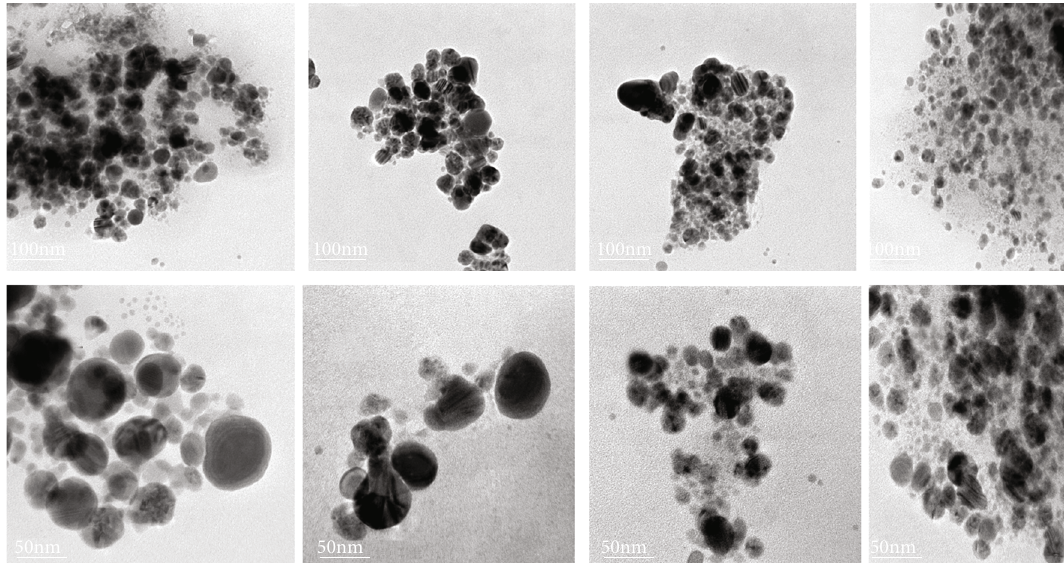
Figure 3: HR-TEM images of HAART-AgNPs (0.5 M) (A1 and A2), HAART-AgNPs (1 M) (B1 and B2), HAART-AgNPs (1.5 M) (C1 and C2), and HAART-AgNPs (2 M) (D1 and